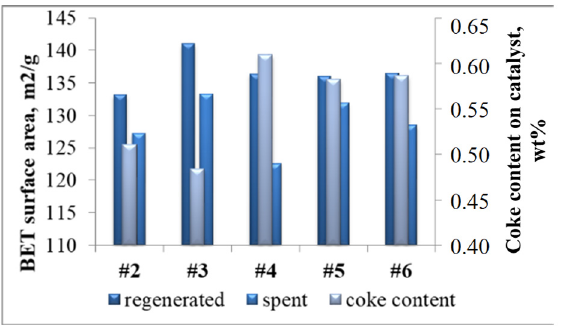
Figure 4. Change in specific surface area and coke content on the catalysts.